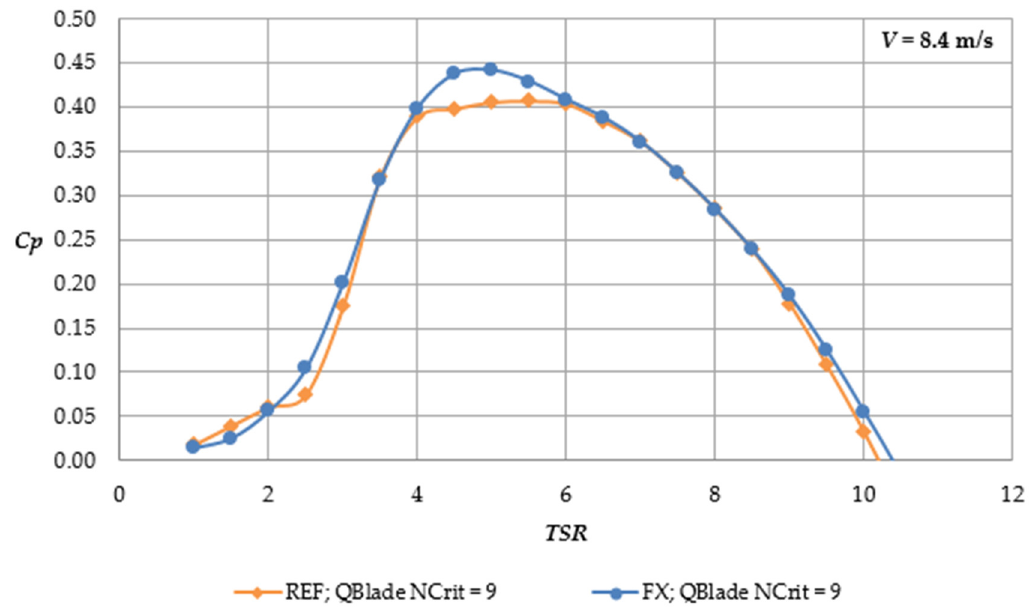
Figure 9. BEM simulation results for the reference (REF) and FX geometry rotors.